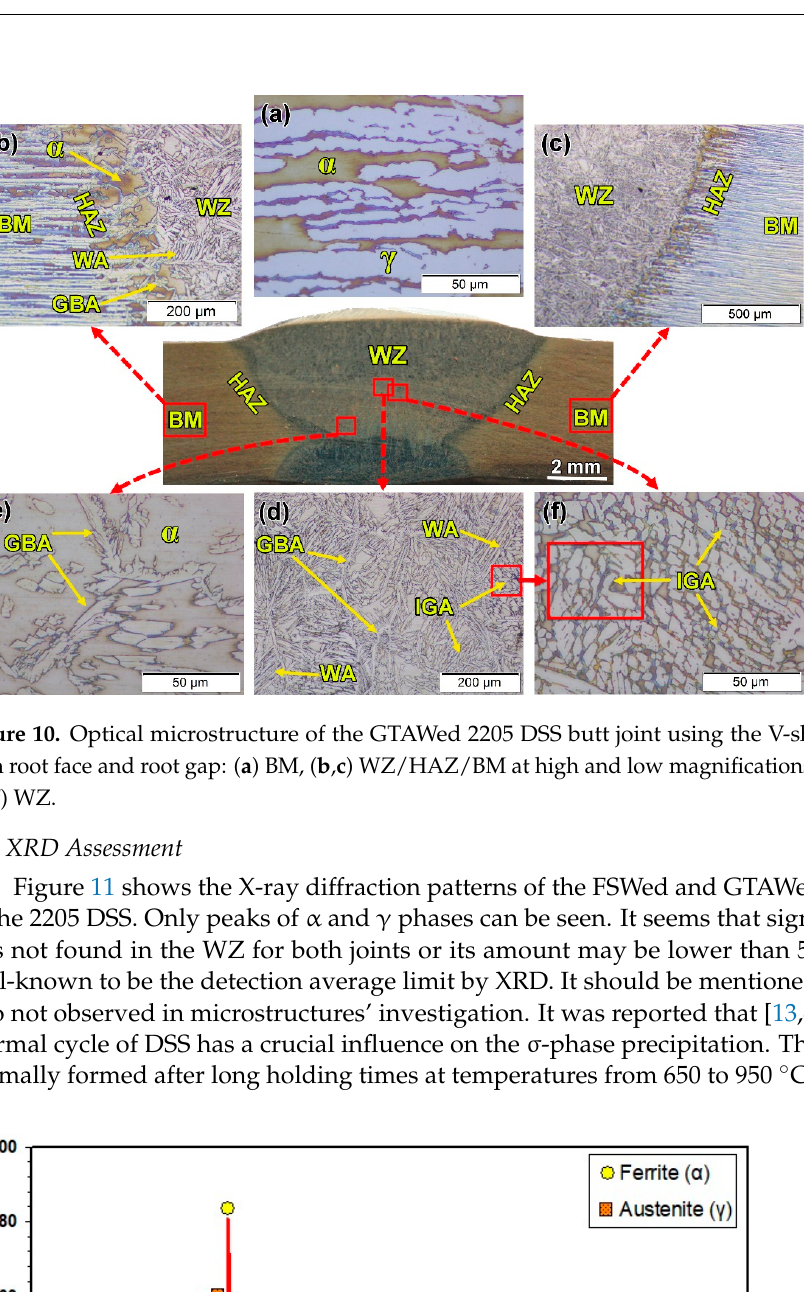
Figure 9. Optical microstructure of the FSWed 2205 DSS butt joint using the V-shaped groove with root face: (a) BM, (b) SZ/TMAZ/HAZ on the advanced side, (c) SZ, and (d) SZ/TMAZ/HAZ on the retreating side.